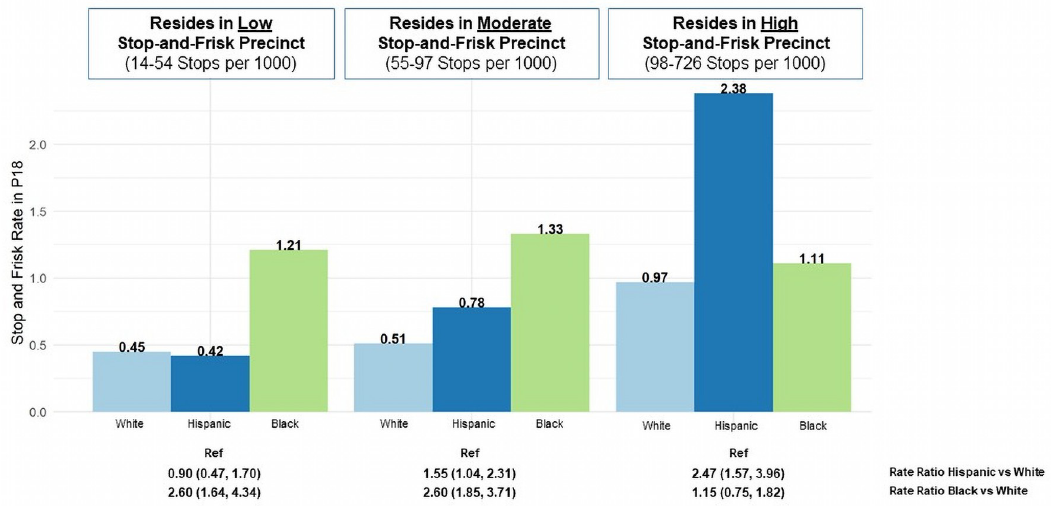
Fig 4. Race differences in past year stop-and-frisk rate among P18 participants at cohort baseline in 2014 by neighborhood- level stop-and-frisk rate (counts/1000) � . � P18 participants were categorized according to their neighborhood-level stop-and-frisk rate, which were calculated as followed. Participant’s ZIP code was translated to latitude and longitude, which was then used to identify the New York City Police Department (NYPD) precinct in which the respondent lived (total of 77 possible precincts). NYPD precinct-level stop-and-frisk rates were calculated as the 2014 NYPD recorded number of stop-and-frisk events divided by the precinct population of male residents aged 20–29 years old; restricted given the younger age range of the P18 sample. The population estimates for New York City were calculated from 2014 estimates from the 2010–2014 5-year American Community Survey; population estimates for each census tract of New York City were calculated after restricting the sample to males aged 20–29 years. Each of the 77 precincts were categorized into group groups based on the precinct-level stop-and-frisk tertile. Within each tertile indicating neighborhood-level stop-and-frisk, stop-and-frisk rates were calculated at the race-specific number of stop-and- frisk events reported by P18 participants/race-specific P18 study